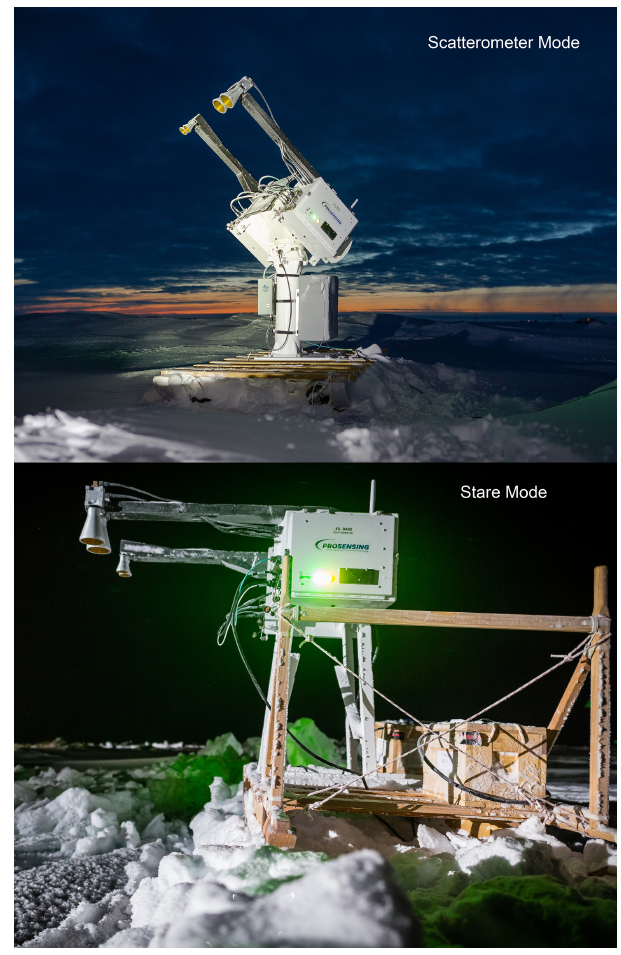
Figure 1. Configuration of KuKa radar in scatterometer scan (top) and altimeter stare (bottom) modes. Photo credit: Stefan